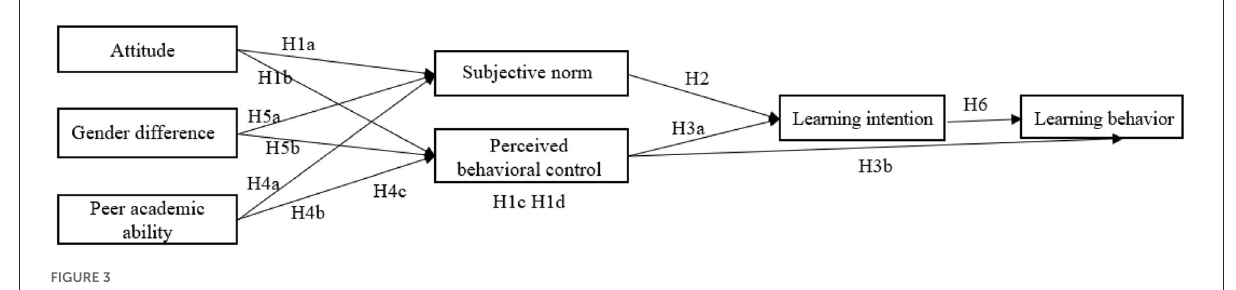
FIGURE3 Conceptual model of PP-LB impact